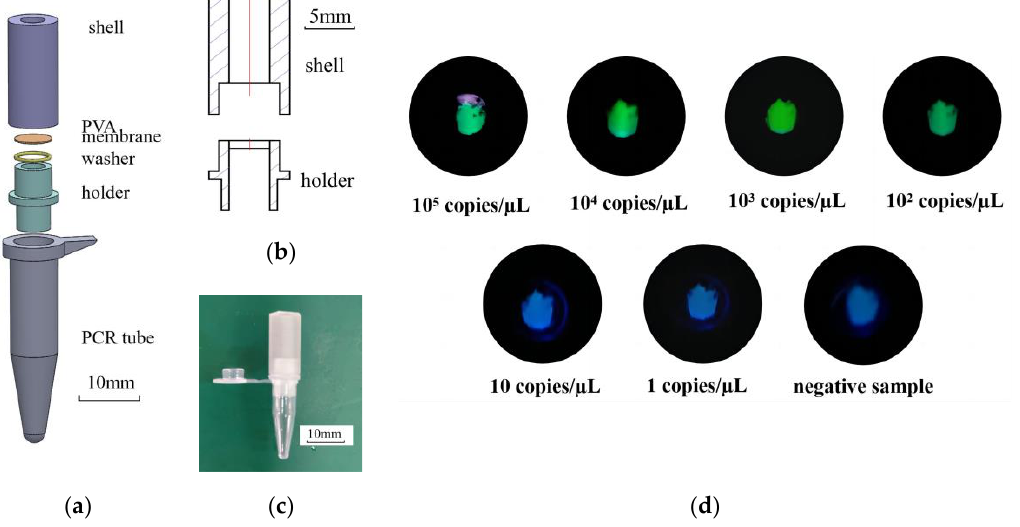
Figure 3. ( a ) Exploded view of the dedicated vessel for LAMP-CRISPR reaction. ( b ) Cutaway view of the dedicated vessel. ( c ) Photograph of the dedicated vessel. ( d ) The DNA solution of gradient concentration and solution for reaction were placed in the vessel. Visualized fluorescent signals can be obtained after 30 min of LAMP reaction and 5 min of CRISPR reaction.